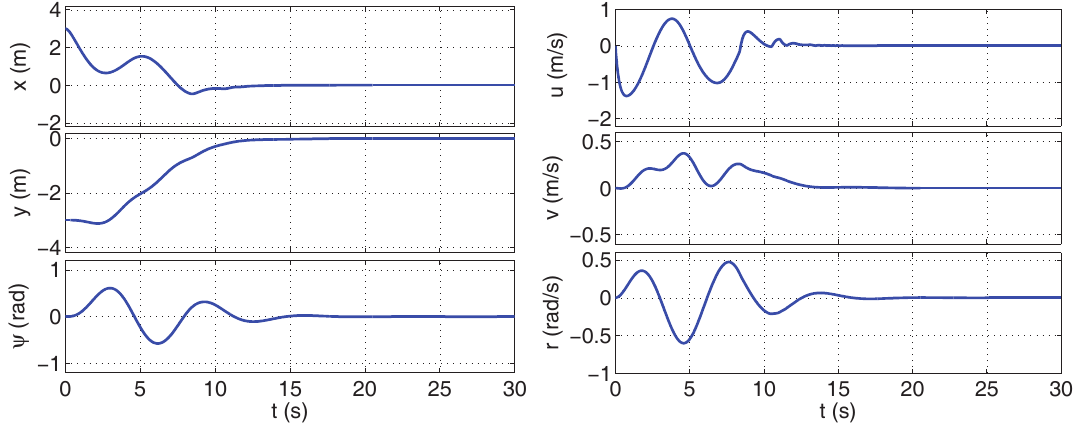
Figure 2. Trajectories of states x , y , ψ , u , v and r